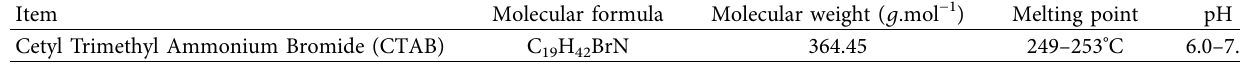
Table 4: Nickel Zinc Iron Oxide (NiZnFe S.